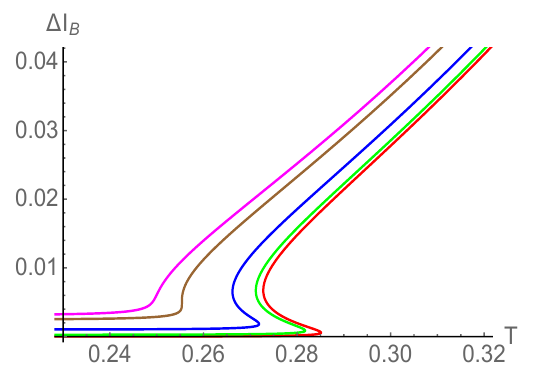
Figure 37 . (cid:1) I B = I Thermal-AdS (cid:0) I Black hole as a function of T for various values (cid:22) . Here ‘ = 0 : 2 B B and x = 0 : 1 are used and red, green, blue, brown and magenta curves correspond to (cid:22) = 0, 0 : 1, 0 : 2, 0 : 312 and 0 : 35 respectively. In units